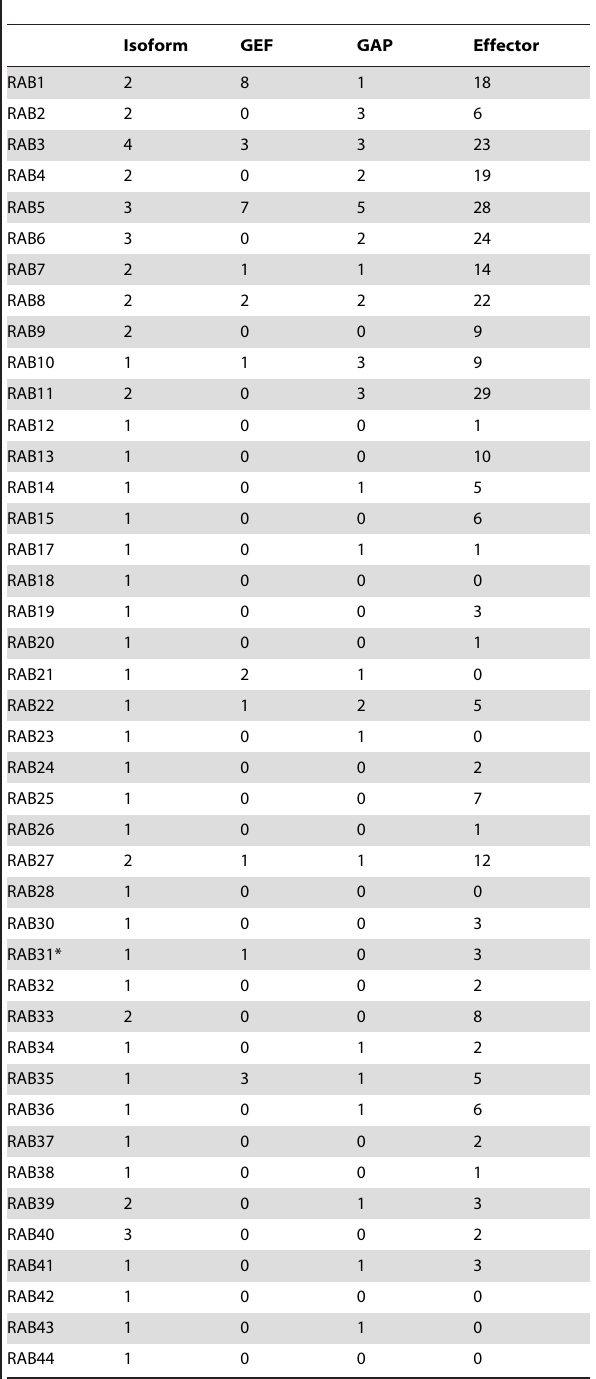
Table 1. Number of isoforms, GEFs, GAPs and effector proteins analysed for each Rab